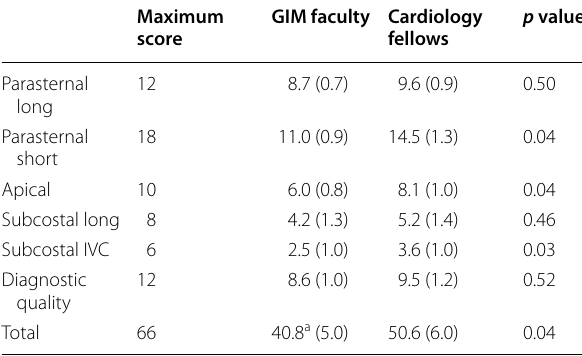
Data reported as model-adjusted means (SE) combining the three assessment sessions. Comparisons reported using adjusted p value GIM general internal medicine faculty, SE standard error a Model adjusted mean reported, so total does not equal sum of individual